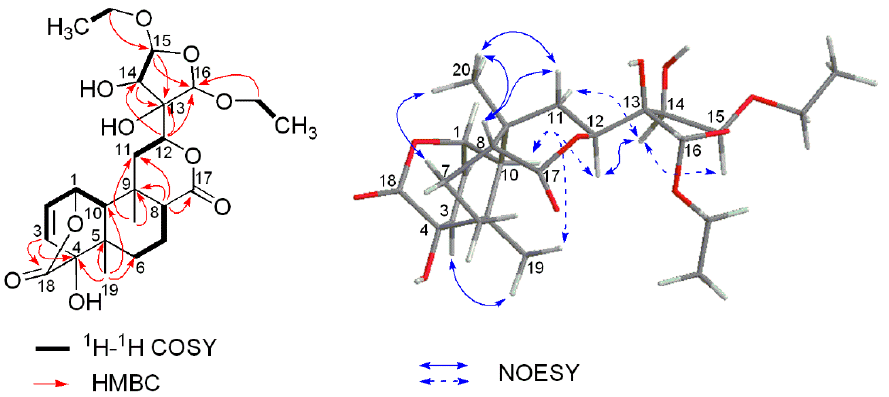
Figure 4. Key 1 H- 1 H COSY, HMBC and NOESY correlations of 2 .